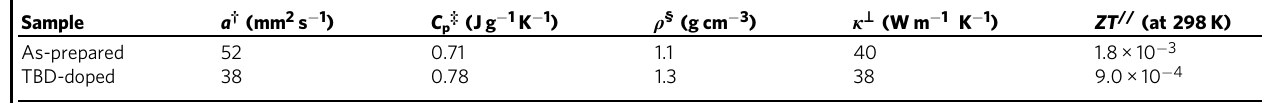
Table 2 Thermal properties and dimensionless fi gure of merits for as-prepared and TBD-doped EC1.5-CNT fi lms measured at 298 K in air. TBD doping was performed by immersing the CNT fi lm in the DMF solution of TBD with a concentration of 71 mM.